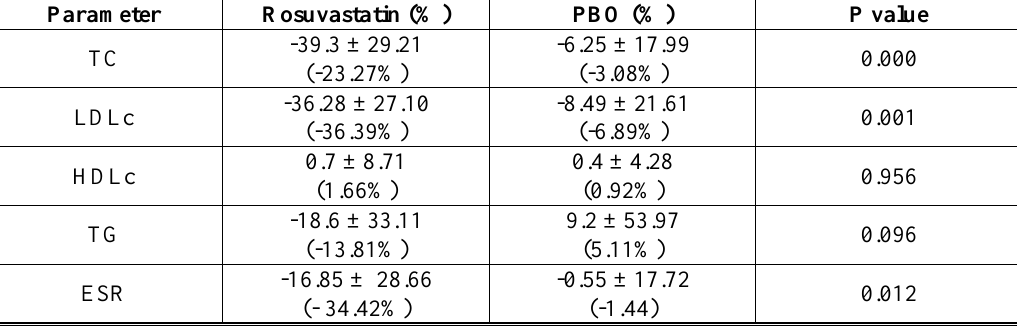
Table (4) Change produced in lipid profile and ESR after 8 weeks of treatment with either rosuvastatin or